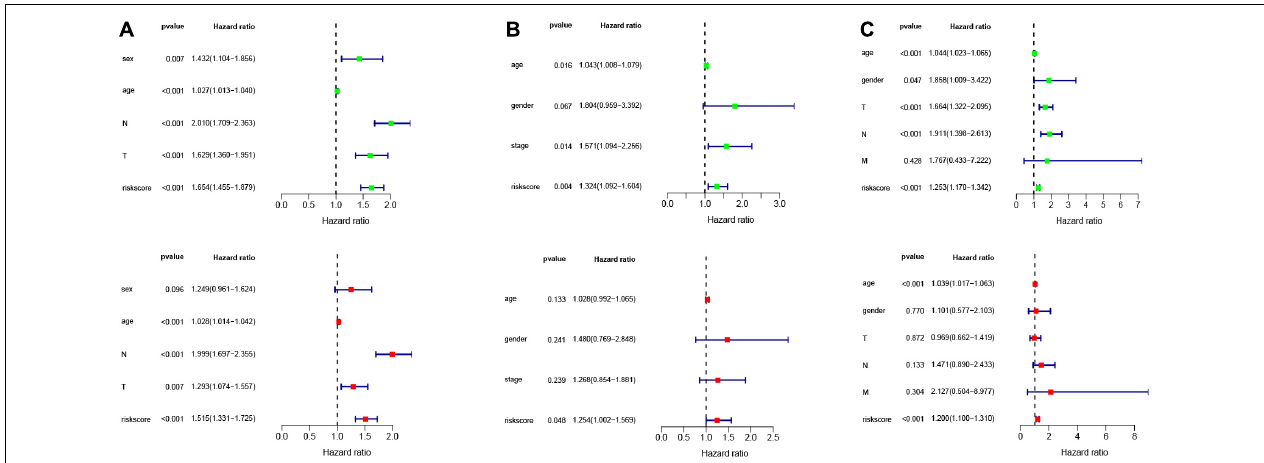
FIGURE 5 | Univariate and multivariate Cox analysis of the signature combined clinical features. Univariate and multivariate Cox analysis in (A) GSE68465 (B) GSE42127 (C) GSE30219.